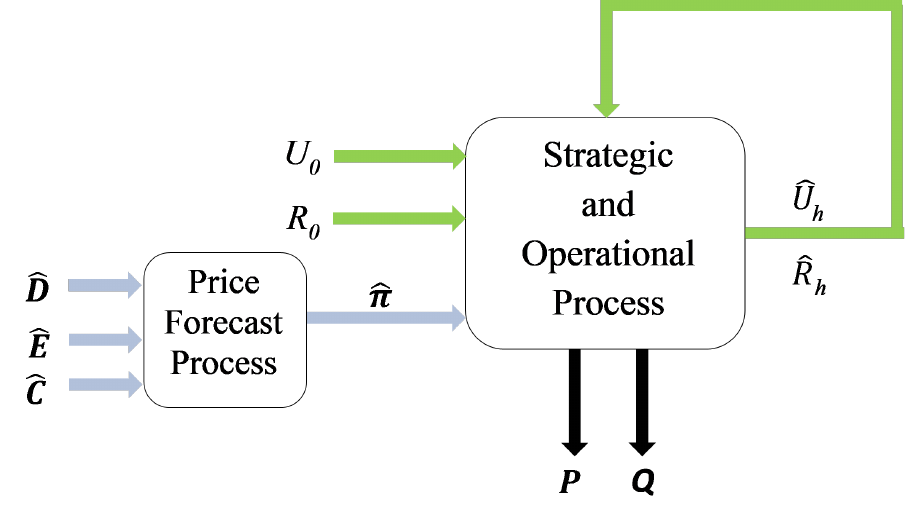
Figure 2. Important variables associated with the operation of hydroelectric power plants.